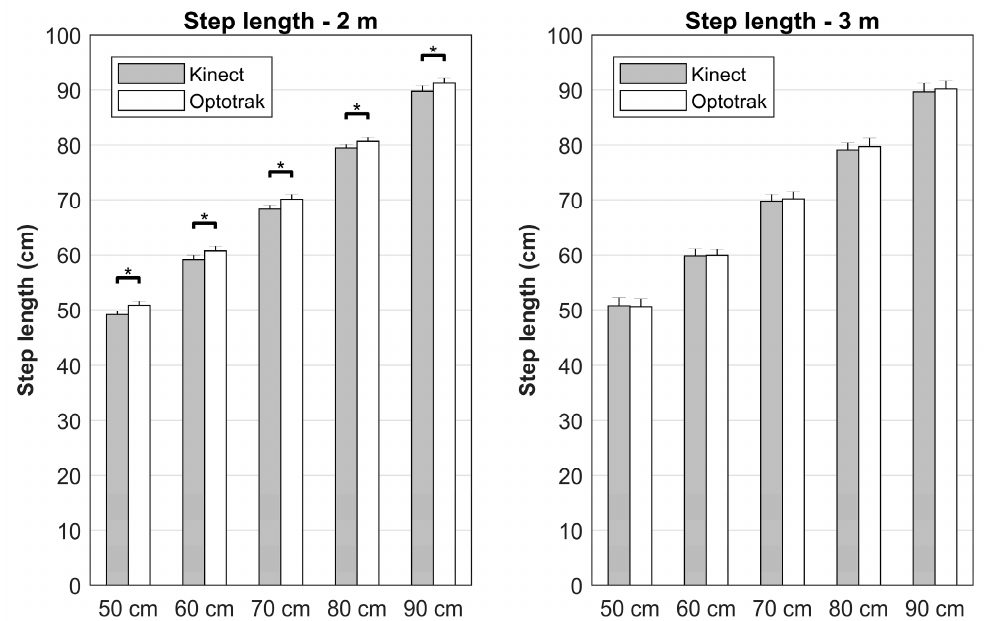
Figure 4. Visual representation of the interaction effect of System, Distance and Imposed step length. Significant between-systems differences in step length were only found at 2 m, with larger biases for larger imposed step lengths.